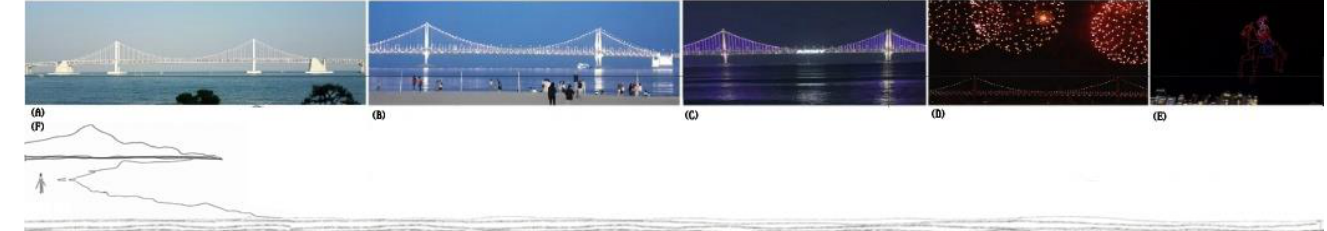
Figure 4. The appearance of Diamond Bridge before the 1993 construction started and the landscape media facade after the construction started in 2003 at Gwangalli Beach, Busan. ( A , B ) general life information media color (2019), ( C ) BTS concert event period (2022), ( D ) Fireworks Festival (2018), ( E ) Drone Shows (2022), ( F ) Natural scenery before the construction of the Diamond Bridge. Table 1. Media interaction space type: (A), (B) Two types of (a) screen, (b) façade, (c) object media technology expression analyzed according to physical architecture and object structure form.